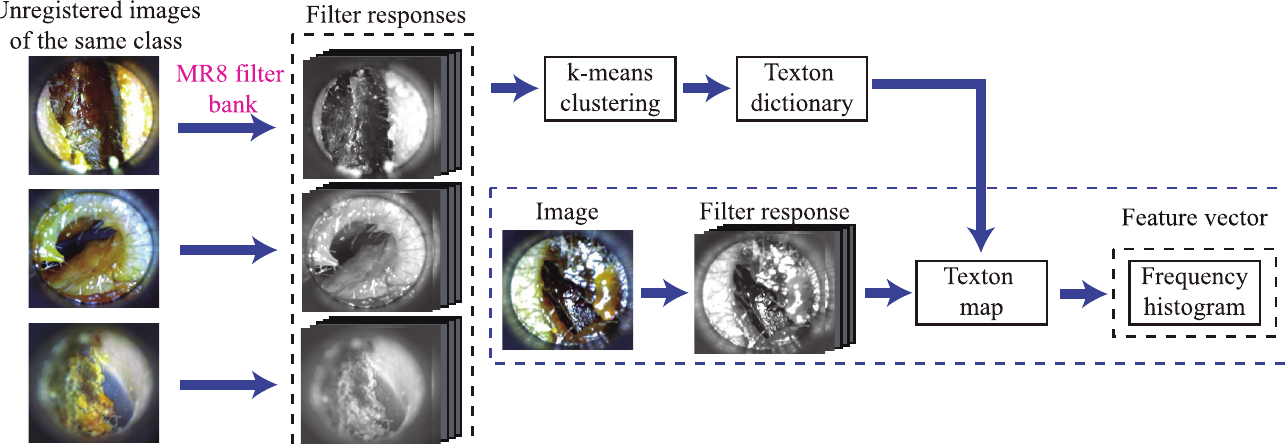
Fig 4. Scheme implemented to generate the feature space based on filter-bank method. The first stage consists in a texton dictionary creation. Such dictionary is used to label the new filter responses to an image from the training set. The second stage computes a histogram of the frequency of each texton occurrence in the labeling stage for each filter response. The frequency histogram is considered as the feature vector.